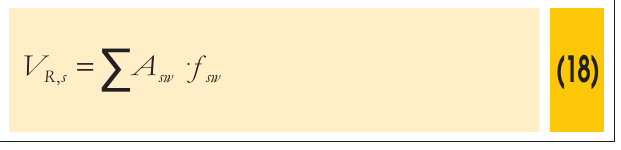
Where: Σ is made for the shear reinforcements cut by the rupture superficies; Asw is the steel area of a layer of the shear reinforcement; fsw is the stress on each reinforcement layer, one in func- tion of the details of the shear reinforcement and of the vertical displacements δ v (see Equation 19) in each reinforcement layer at the point intercepted by the rupture superficies (see Table